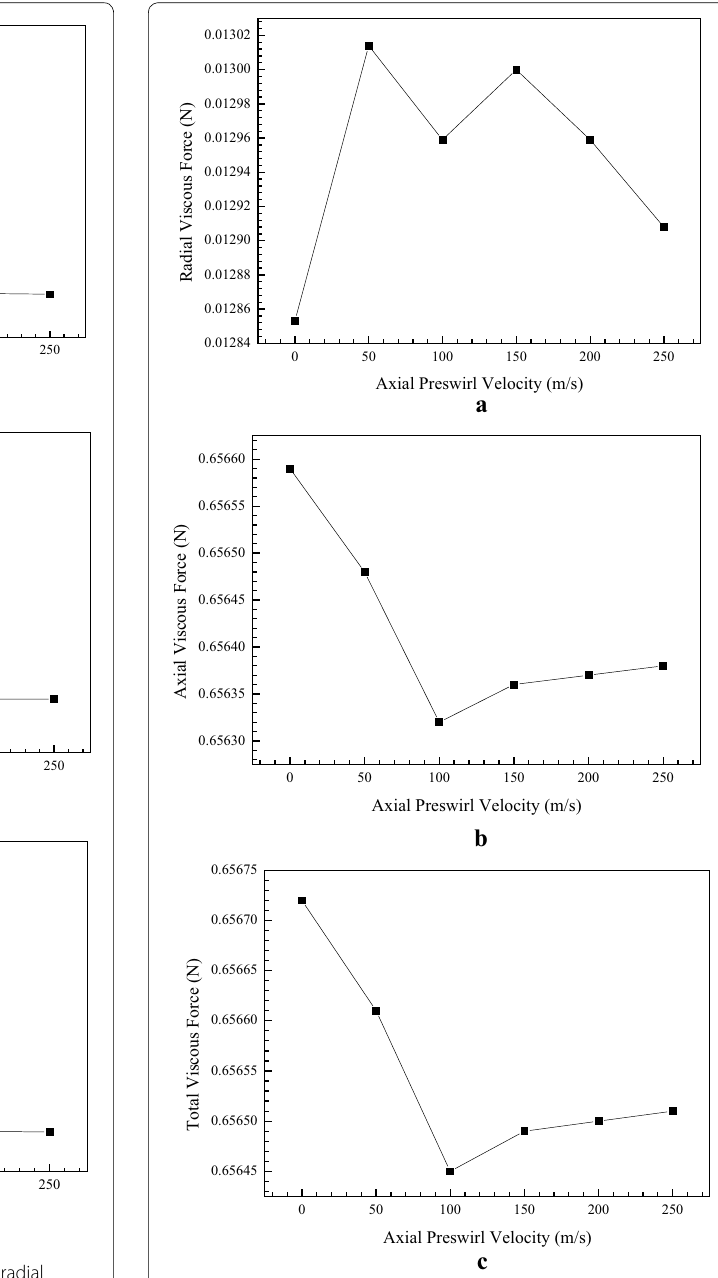
Figure 6 Pressure forces versus axial pre-swirl velocity: a radial pressure force; b axial pressure force; c total pressure force Figure 7 Viscous forces versus axial pre-swirl velocity: a radial viscous force; b axial viscous force; c total viscous